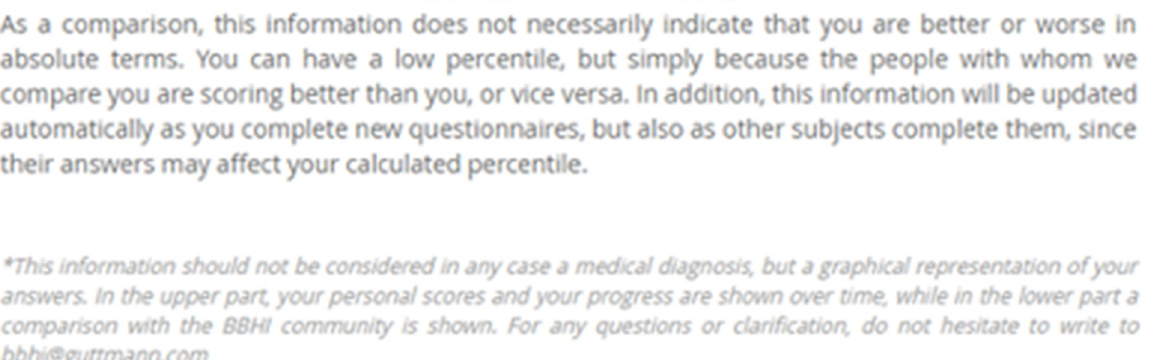
Fig 3. An example of a participant’s change in lifestyle adherence over time: comparison of responses in the first wave of questionnaires and at the follow-up.